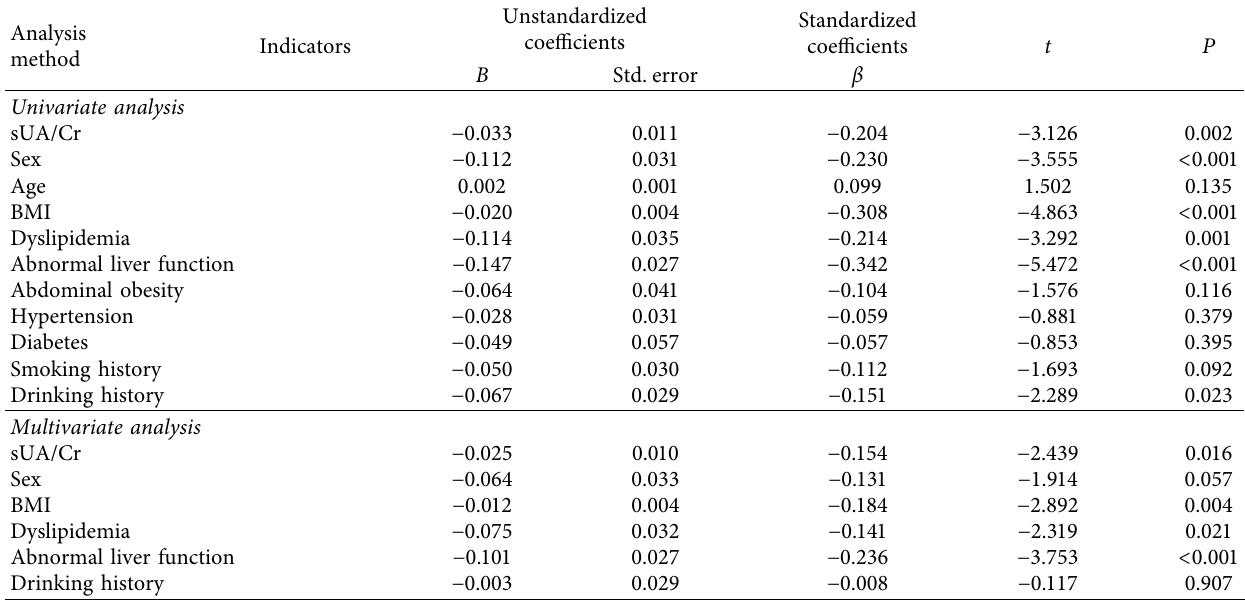
Table 3: Univariate and multivariate linear regression analyses of liver/spleen computed tomography